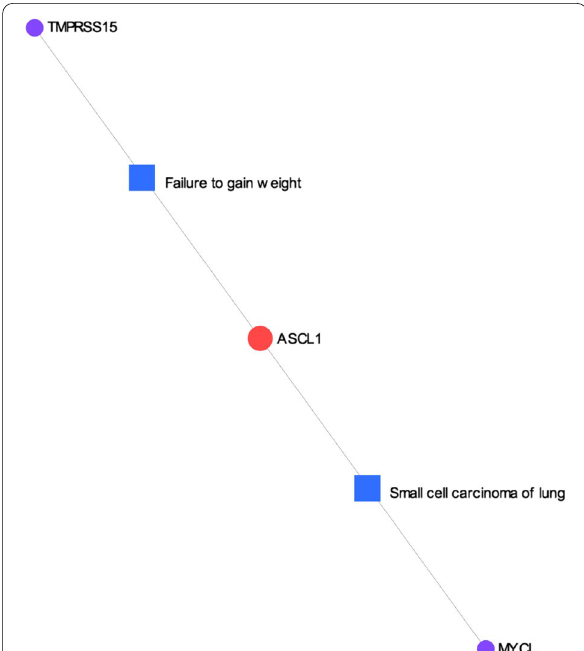
Fig. 5 Gene-disease network analysis for identified significant DEGs. The identified DEGs are illustrated by circles and associated diseases are presented by squares